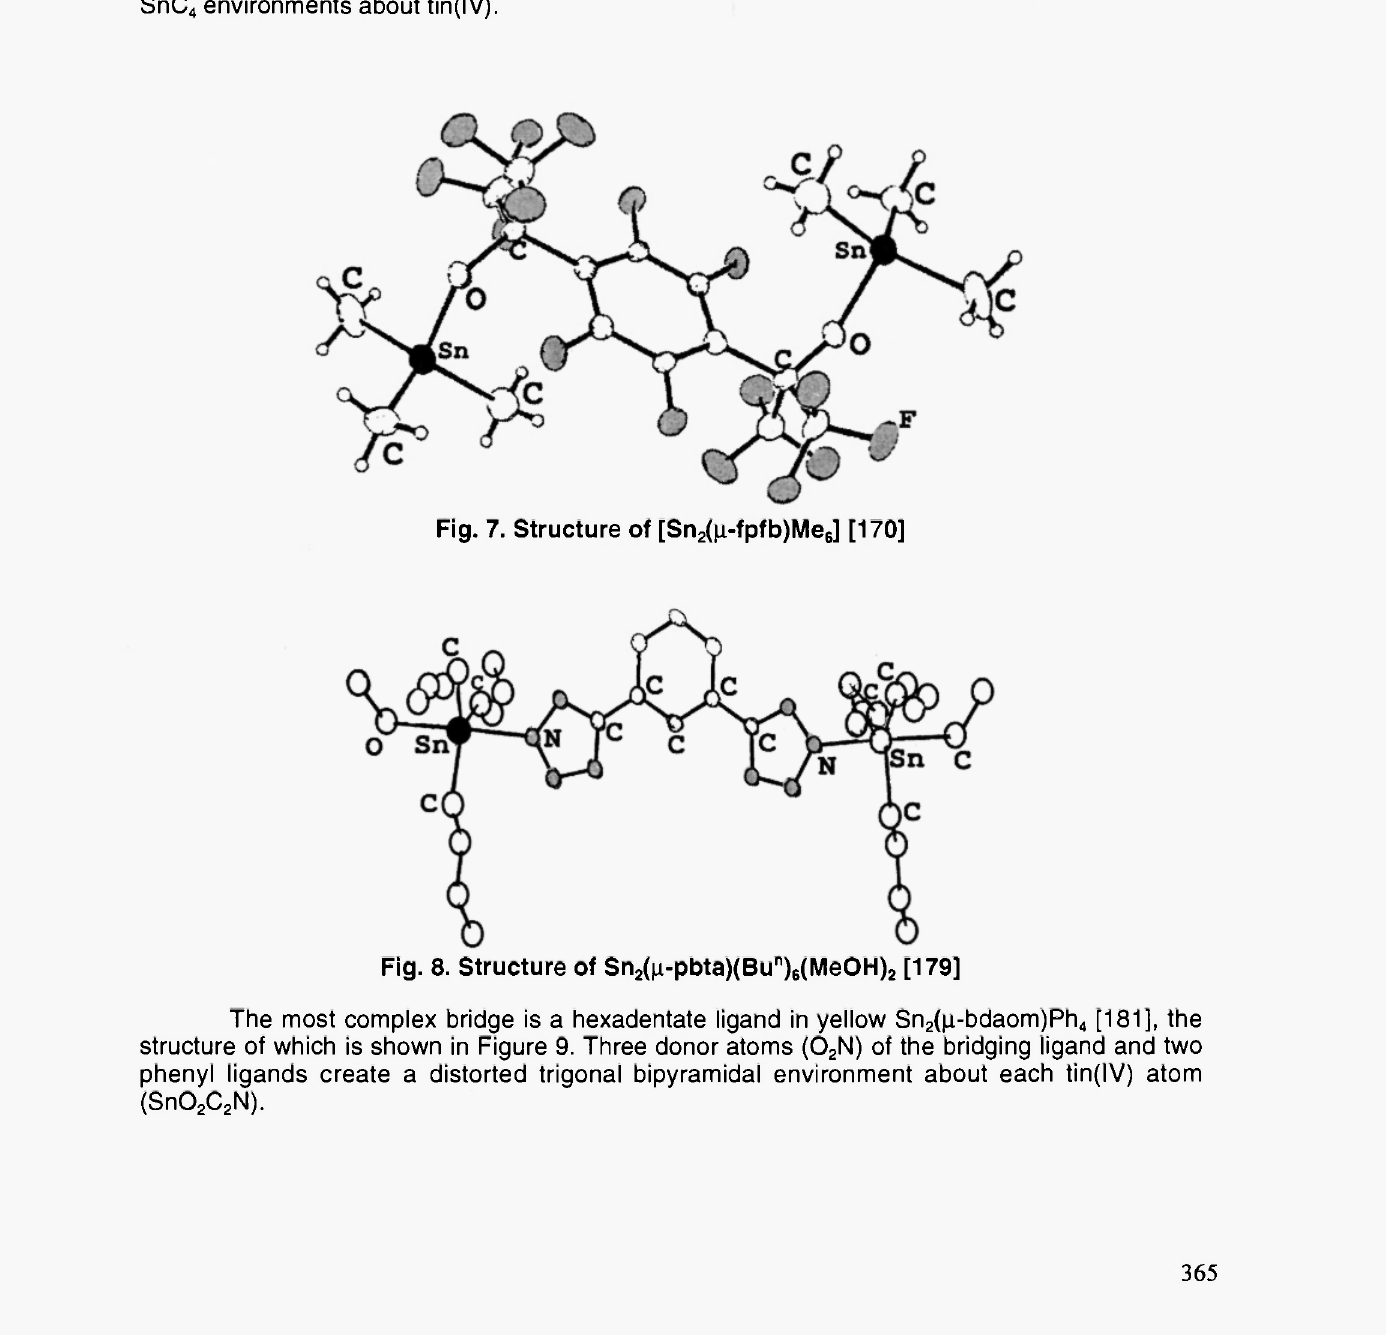
Fig. 7. Structure of [Sn 2 ^-fpfb)Me 6 ] [170]